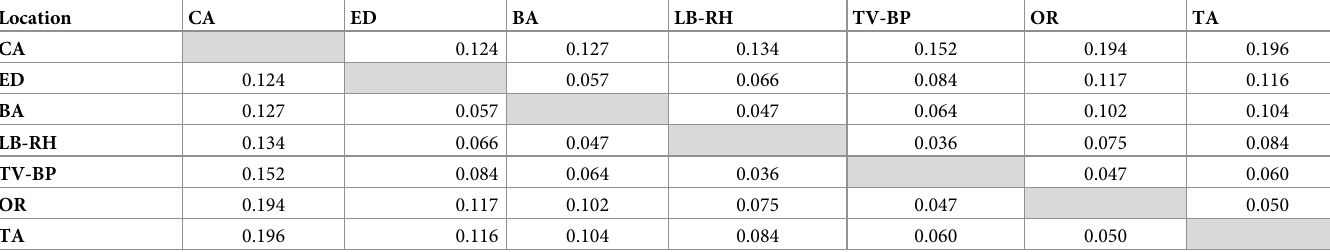
Table 5. Pairwise F ST values for Ae . aegypti collected in Buenos Aires and in Northeastern and Northwestern Argentina localities.